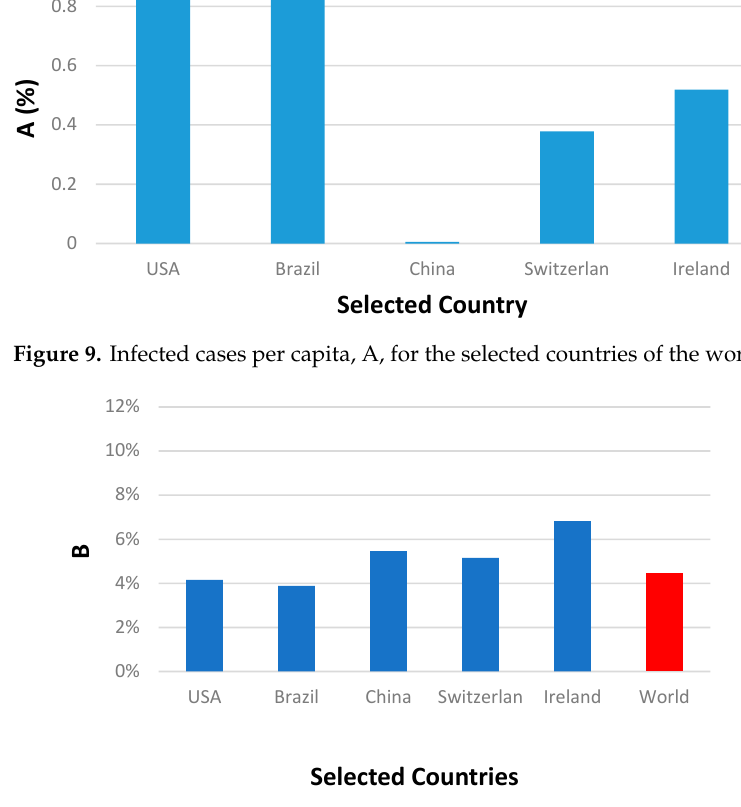
Figure 10. Deaths per infected individual percentage, B, for the selected countries and the world.